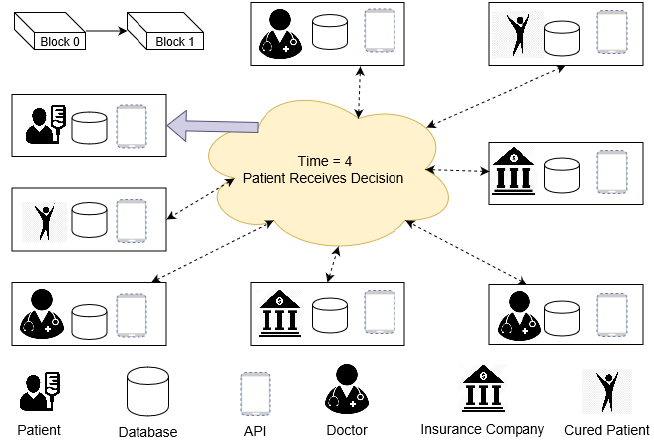
Figure 12. At time 4: The patient receives the final collaborative medical decision.